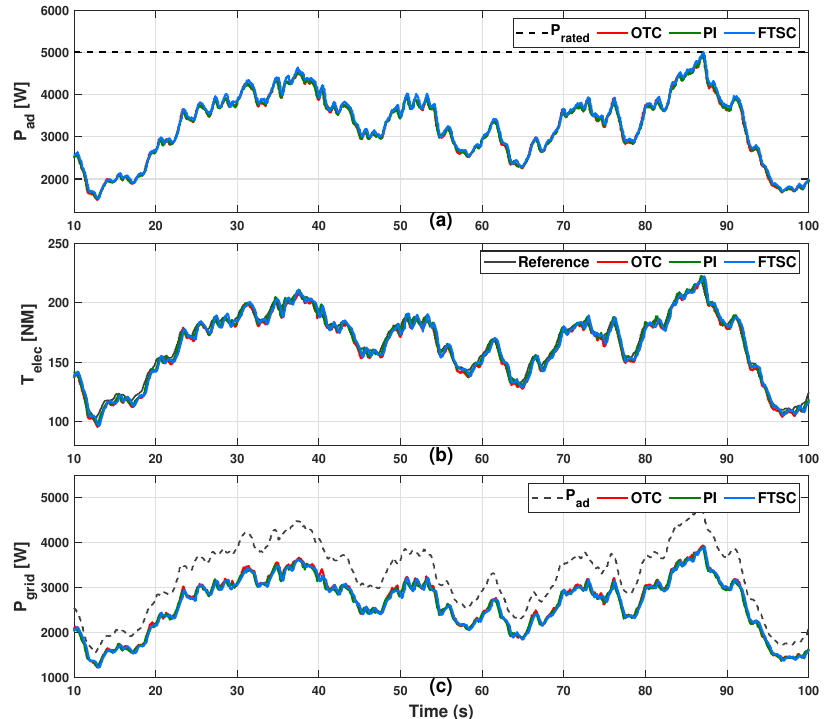
Figure 23. Experimental comparative evaluation of PMVG-based WECS under varying wind profile case-I . ( a ) Aerodynamic power. ( b ) Electromagnetic torque. ( c ) Power transfer to utility